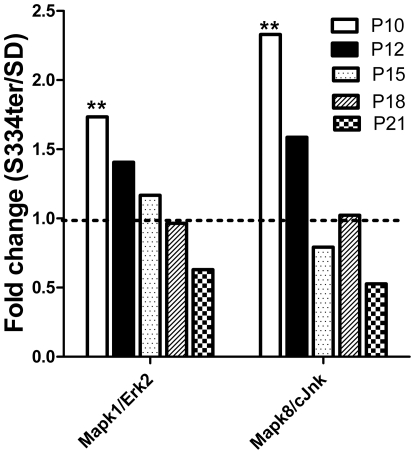
Relative expression of the MAPK1 (Erk2) and MAPK8 (JNK) genes in S334ter-4 Rho retinas.Relative gene expression in S334ter-4 Rho retina was measured on P10, P12, P15, P18 and P21 and a fold change was expressed as a ratio of S334ter-4Rho relative expression to SD relative expression. On P10, the Mapk3 (Erk1) and Mapk14 (p38) gene expression was upregulated 1.7- and 2.3-fold in S334ter-4 Rho retinas, respectively (P<0.01 for both). Starting on P12, their expression decreased with time.